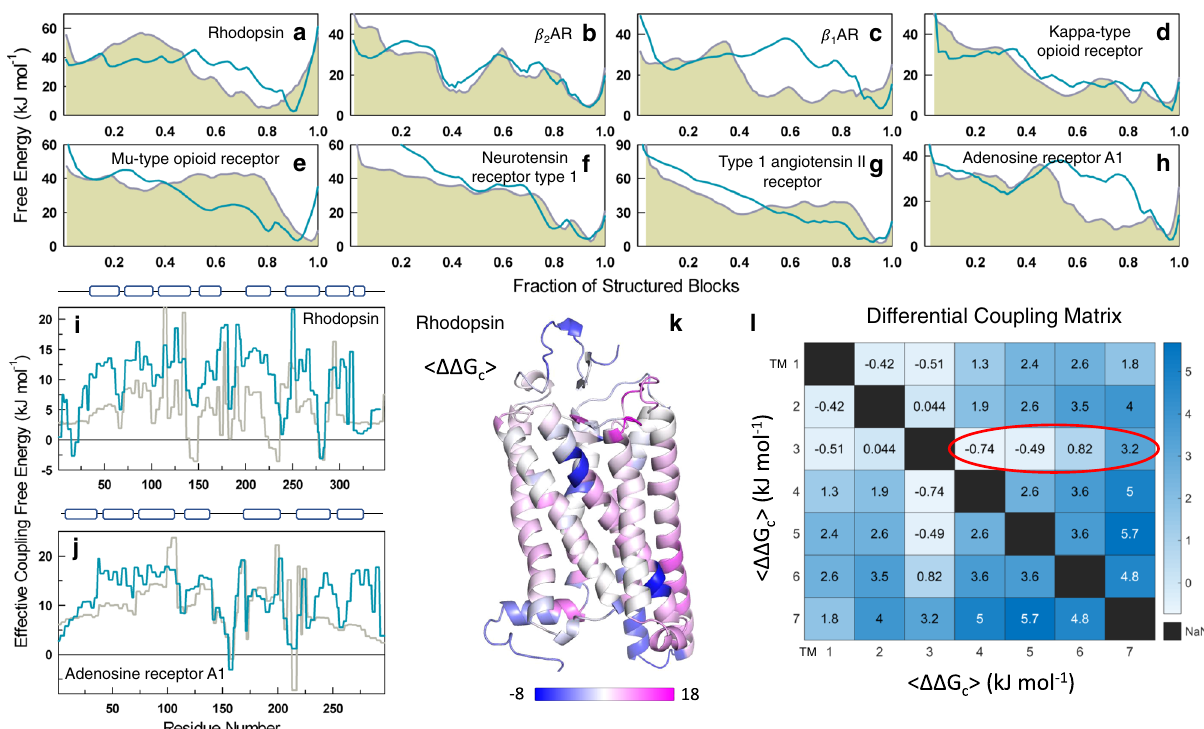
Fig. 6 | Active versus inactive states. a – h Free energy pro fi les derived from the inactive (gray fi lled) and active (dark cyan) GPCR structures at 310K. i , j Effective freeenergiesasafunctionofresidueindexfortworepresentativeGPCRs.Grayand dark cyan represent the effective coupling free energies calculated from inactive and active states, respectively. The cartoons on top indicate the position of the secondary structure elements along the sequence. k Differences in effective cou- pling free energy (active minus inactive) from i is mapped on to the structure of